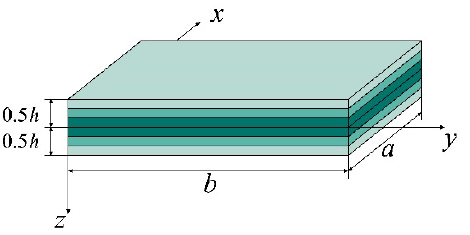
Figure 1. Mode of a functionally graded graphene reinforced composite (FG-GRC) plate.